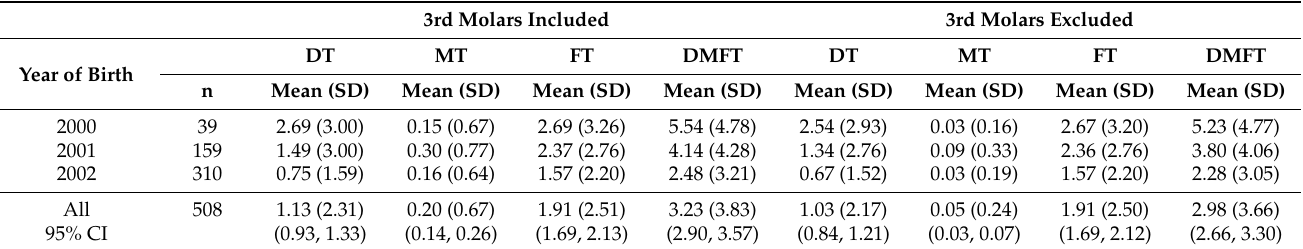
Table 2. DMFT values with and without third